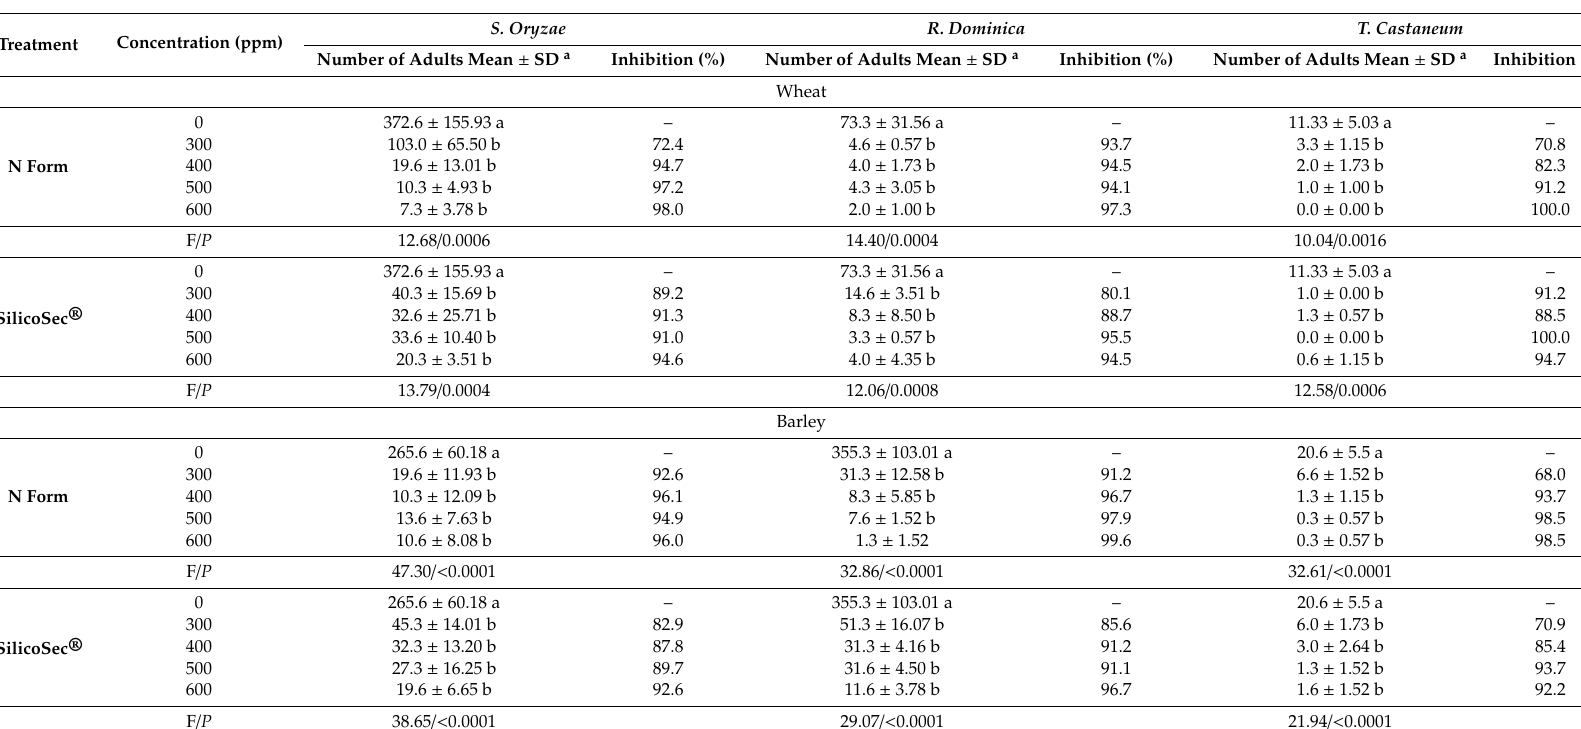
Table 3. Progeny (F1) population of three tested insect species after parent exposure to wheat and barley seeds treated with formulation N Form and DE SilicoSec ® .